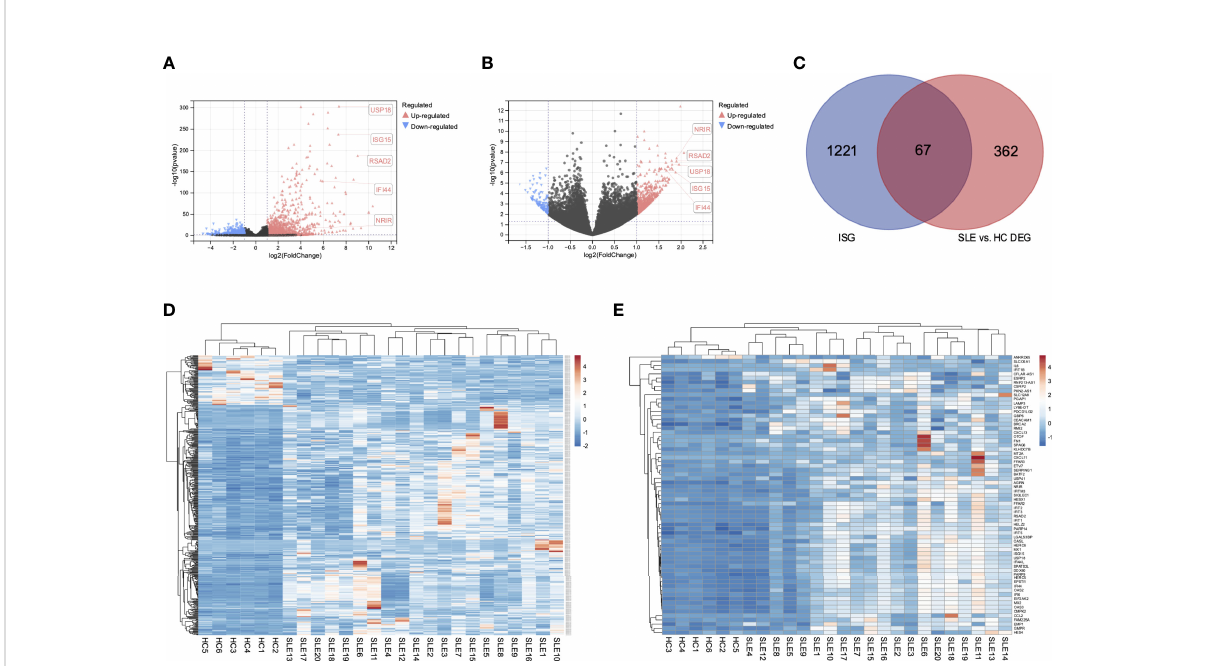
FIGURE 1 Differential expressed interferon-stimulated genes in SLE patients and healthy controls. (A) Volcano of the DEGs of GSE159094. (B) Volcano of the DEGs of GSE122459. (C) Venn diagram of the overlapped DEGs of two datasets. (D) Heatmap of the 429 DEGs in SLE patients and healthy controls. (E) Heatmap of the 67 DEISGs in SLE patients and healthy controls.